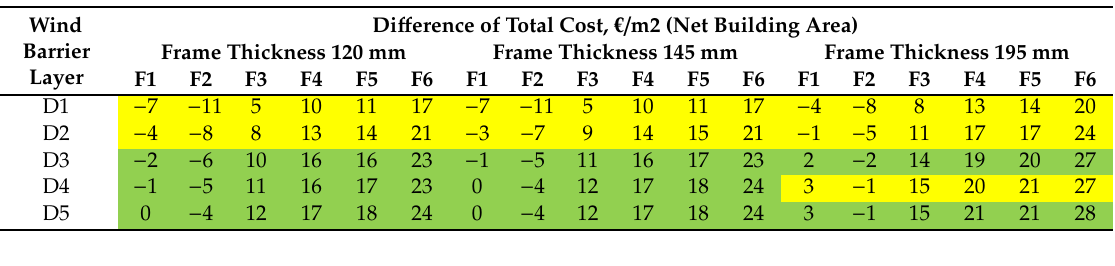
Table 11. Difference between the cost of insulation elements in relation to the set: framing 145 mm + A + B1 + C1 + D5 + E + F1. See Table 1 for description of layers A–F.